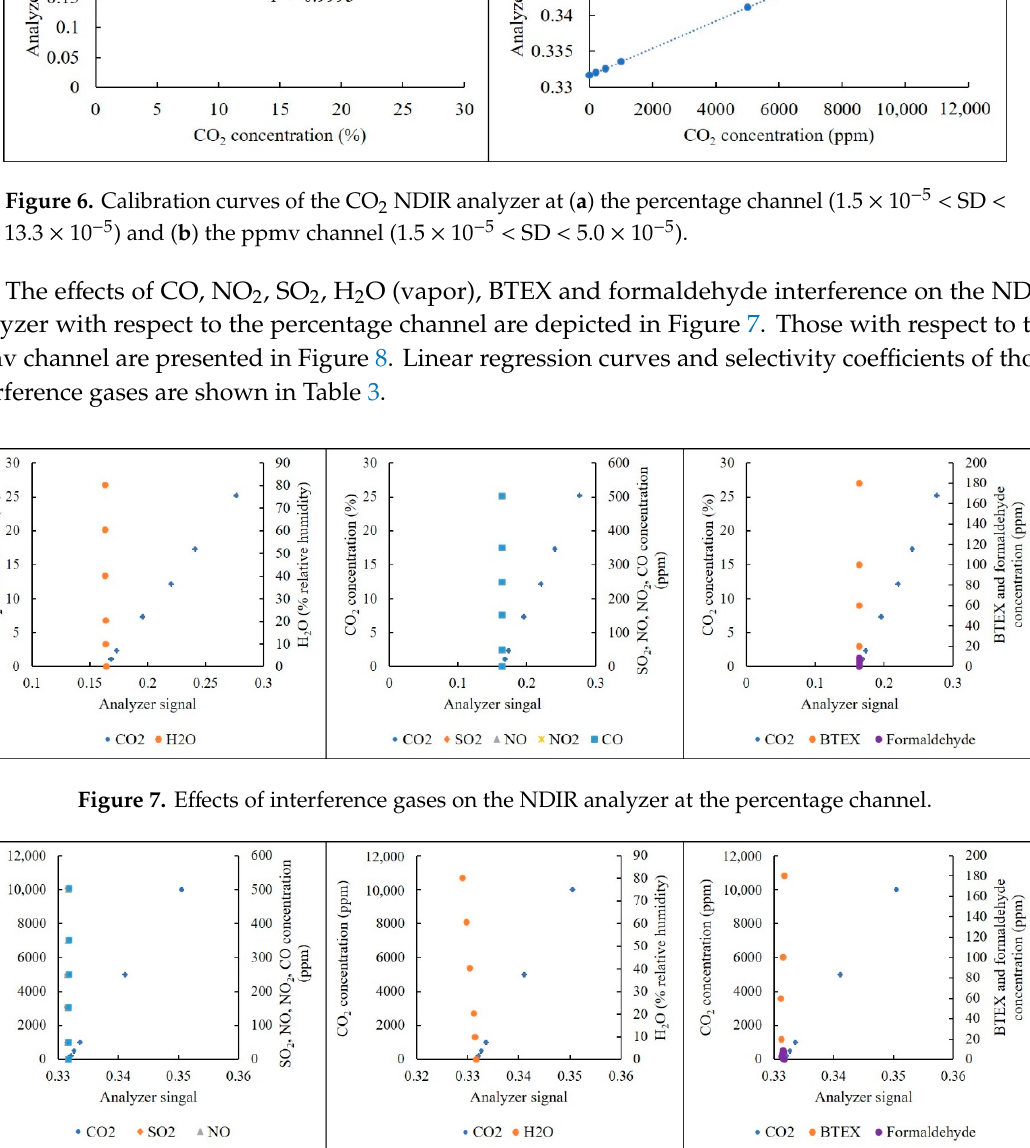
Figure 6. Calibration curves of the CO 2 NDIR analyzer at ( a ) the percentage channel (1.5 × 10 − 5 < SD < 13.3 × 10 − 5 ) and ( b ) the ppmv channel (1.5 × 10 − 5 < SD < 5.0 × 10 − 5 ).